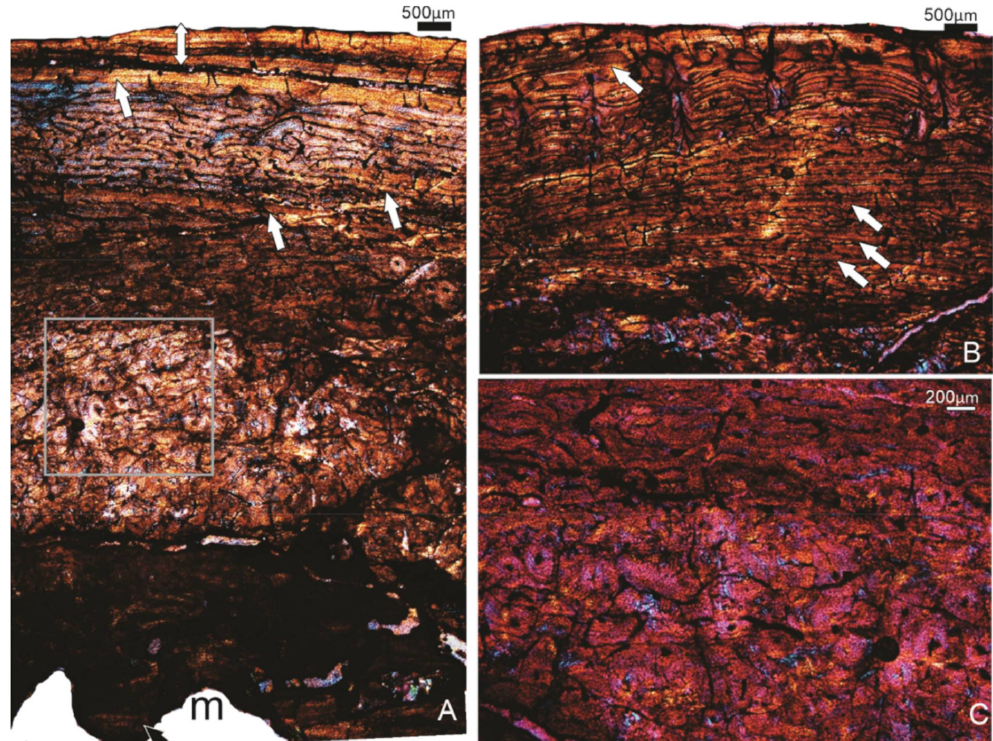
Figure 4. Specimen SAM P.54334; tibiotarsus. ( A ) Overview of the compacta showing an OCL in the peripheral region (double-headed arrow), several growth marks (annuli) (arrows) and a resorptive medullary (m) margin. The black arrow points to remnants of an ICL. ( B ) A different part of the compacta showing four growth marks (arrows) in the compacta. ( C ) Higher magnification of the framed region in ( A ) showing the reticular FBL bone tissue formed during early ontogenetic stages. m, medullary